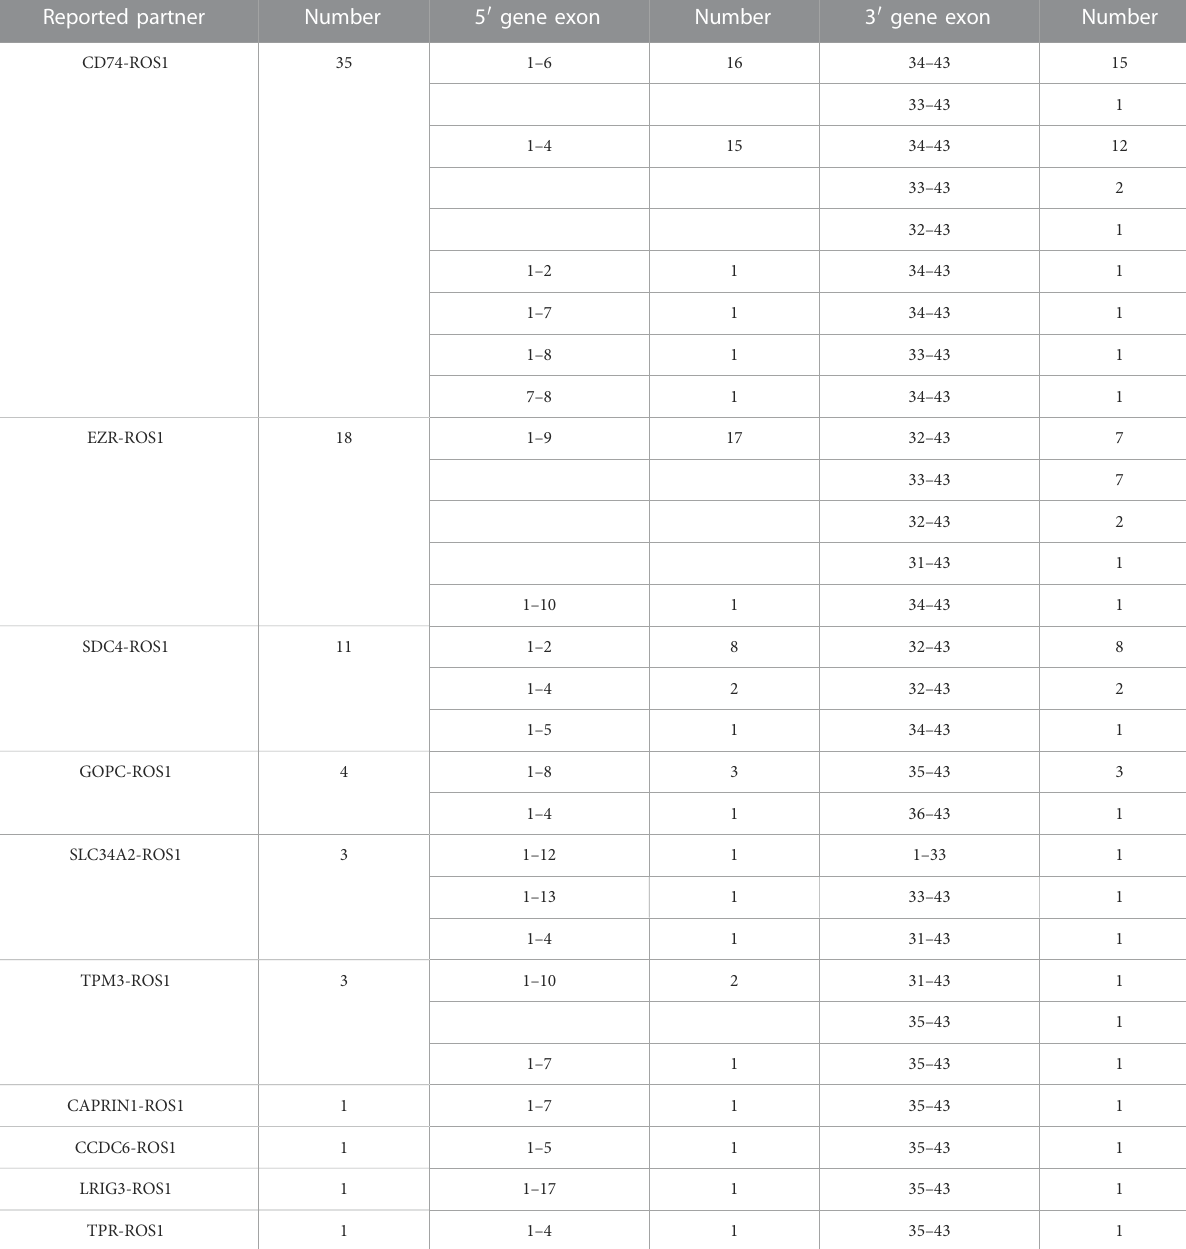
TABLE 2 ROS1 fusion variants described in reported ROS1 fusion